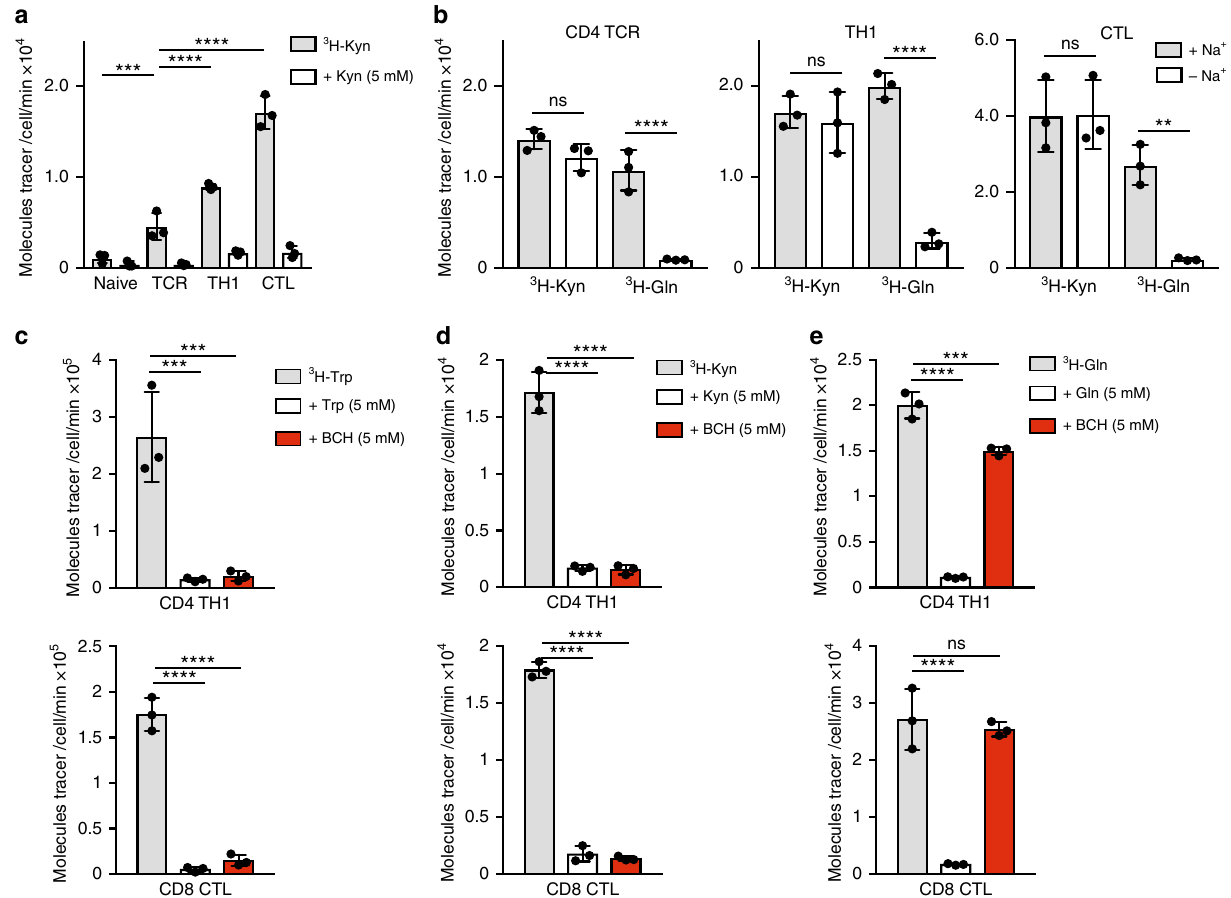
Fig. 1 T cells regulate kynurenine transport through a System L transporter. a Uptake of 3 H-kynurenine (0.1 μ Ci/ml, 4 min, 37 °C) in puri fi ed CD4 + T cells ± TCR activation using CD3/CD28 antibodies for 18 h; in vitro expanded TH1 cells (5 days) and in vitro expanded CTLs (5 days). Cold competition with non-radiolabelled kynurenine is shown as a control for uptake speci fi city. b Uptake of 3 H-kynurenine (0.1 μ Ci/ml, 4 min, 37 °C) or 3 H-glutamine (0.5 μ Ci/ ml, 4 min, 37 °C) performed in Na + containing or Na + -free uptake buffer. The graphs show radiolabelled tracer uptake in puri fi ed CD4 + T cells 48 h post TCR activation using CD3/CD28 antibodies (left panel); IL-2 maintained TH1 cells (centre panel) and IL-2 maintained CTLs (right panel). c – e Radiolabelled tracer uptake in IL-2 maintained TH1 cells (top panels) and IL-2 maintained CTLs (bottom panels) in the presence of non-radiolabelled substrate (5 mM; cold competition) or the System L inhibitor, BCH (5 mM). The graphs show 3 H-tryptophan ( c ), 3 H-kynurenine ( d ) and 3 H-glutamine ( e ). Error bars are ±s. d. Individual points represent biological replicates. a – e Three biological replicates. P values * = < 0.01; ** = < 0.005; *** = < 0.001; **** = < 0.0001; ns = not signi fi cant (ordinary one-way